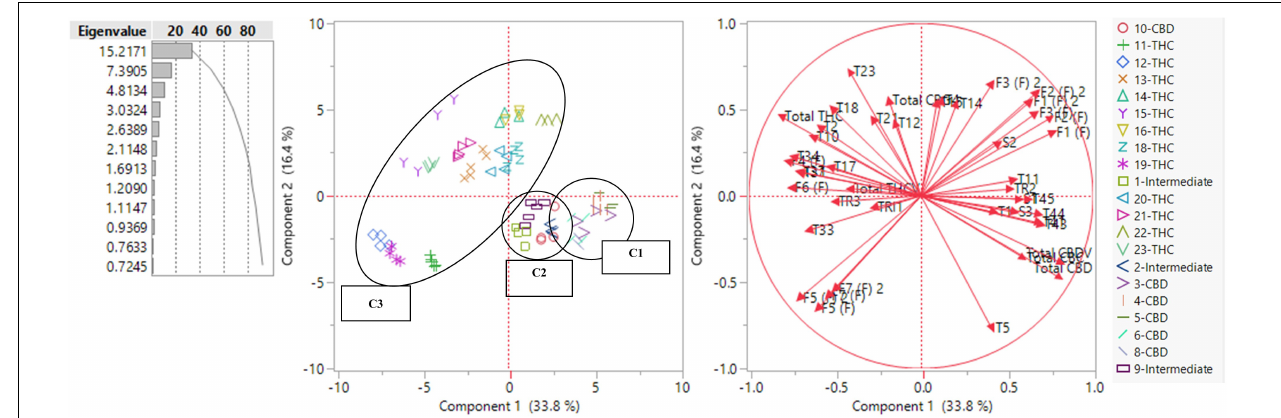
Table 2.7 . Flavonoids quantified in inflorescences are labeled (F) and flavonoids in leaf are labeled (L). Sterols are labeled as S and the number assigned in Supplementary Table 2.9 . Triterpenoids are labeled as TRI and the number assigned in Supplementary Table